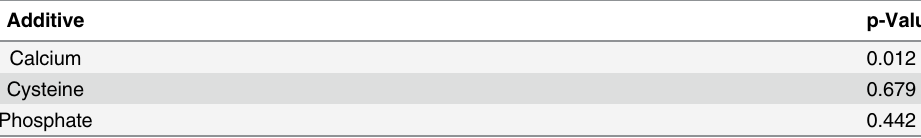
Table 7. Analysis of Variance for Z-average Particle